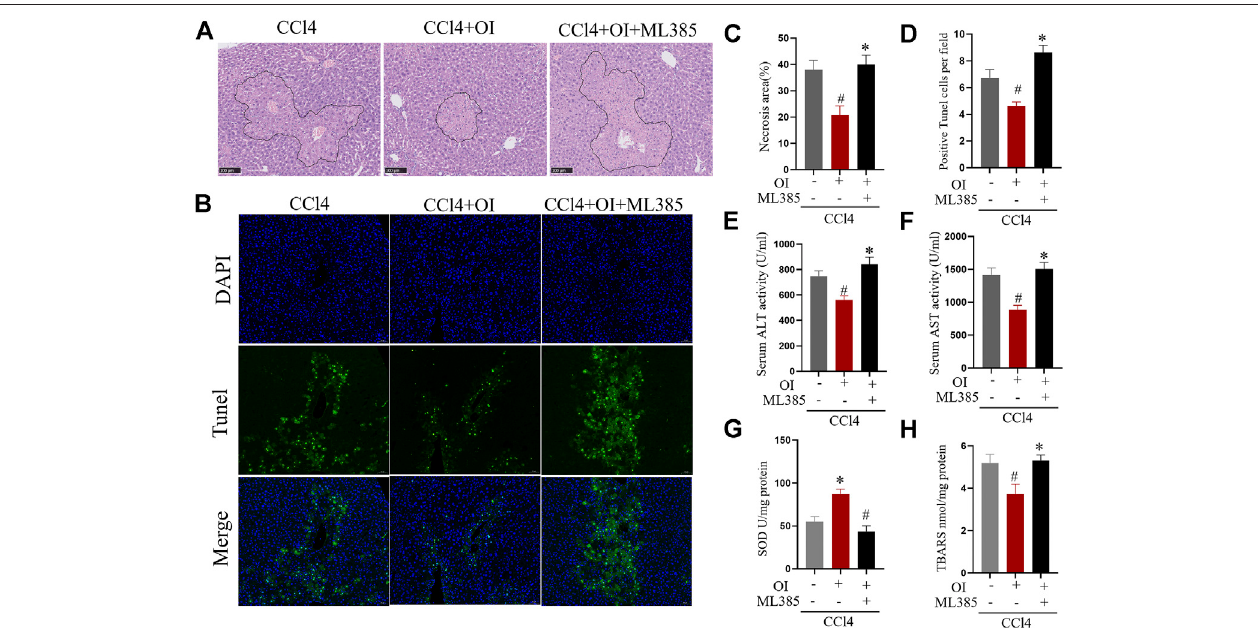
FIGURE 5 | ML385 diminished the protective effects of OI in CCl4-induced liver injury in mice. Representative H&E staining images for the necrotic area (A) and TUNELstaininghepatic sectionsfornecroticcells (B) fromtheCCl4,OI+CCl4OI+CCl4+ML385group.ML385 blockedtheprotectiveeffectofOI.Next, thestatistical analysisofnecroticarea (C) andquanti fi cationofTUNEL-positivecells (D) wereperformed.SerumactivitiesofALT (E) andAST (F) wereanalyzedinCCl4,OI+CCl4,and OI + CCl4 + ML385 groups. SOD (G) activity and the level of TBARS (H) were analyzed in the CCl4, OI + CCl4, and OI + CCl4 + ML385 groups. Original magni fi cation, × 200. Data were expressed as mean ± SEM ( n (cid:1) 5 for each group); # p < 0.05 vs. CCl4 group; * p < 0.05 vs. CCl4 + OI group.